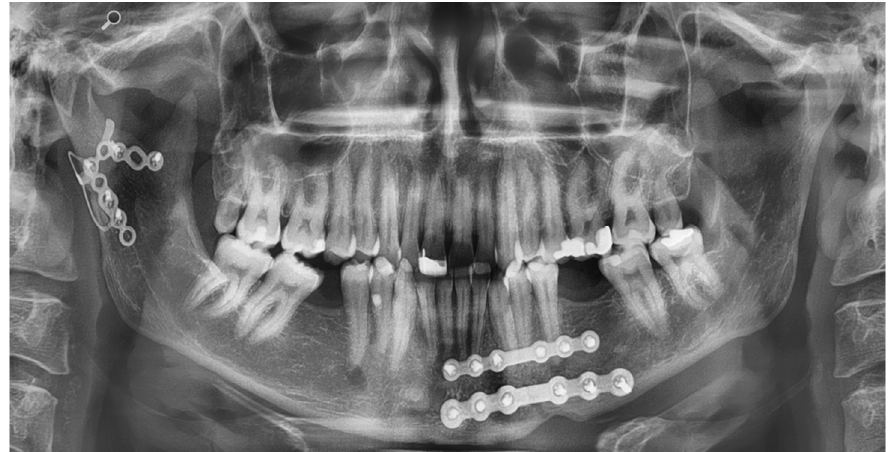
Figure 6. Visualization of the application of the condyle plate, with a modification to hold the upper segment.